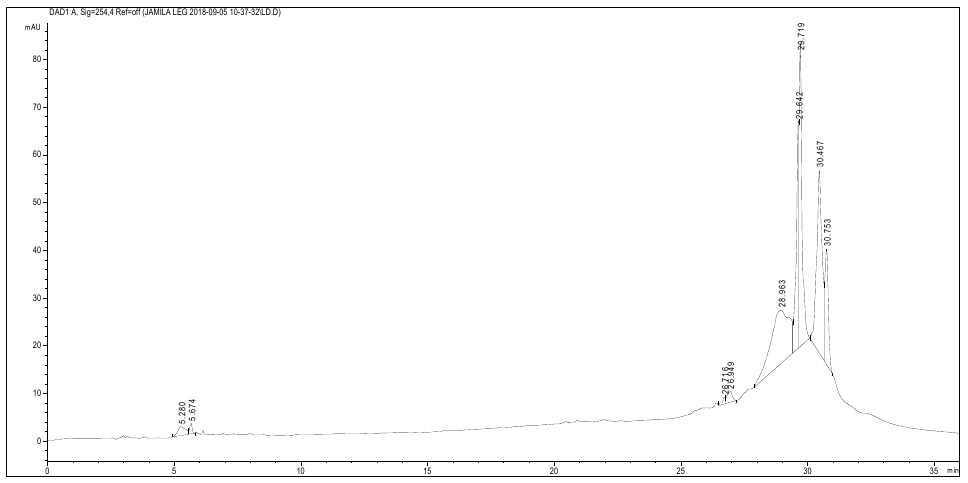
Figure 1. HPLC chromatogram of methanolic extract of M. vulgare.